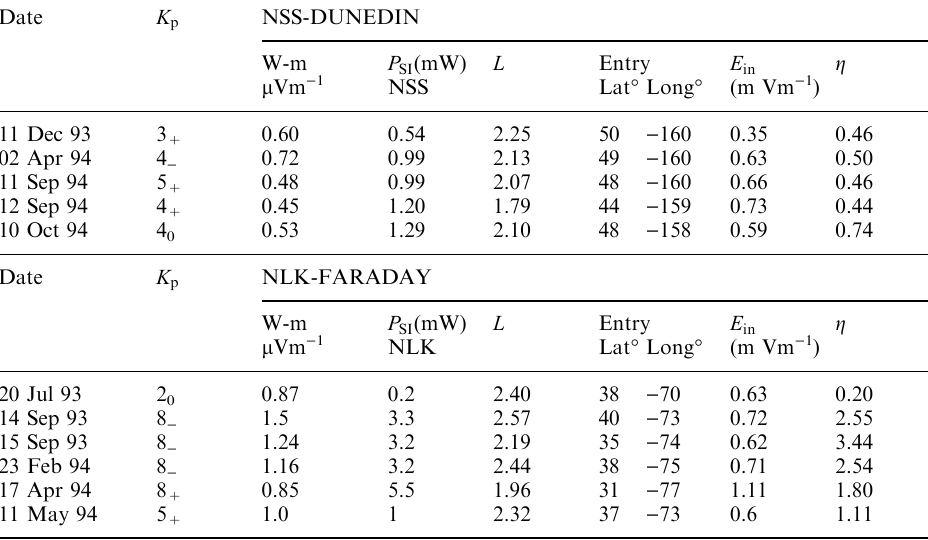
Table 1. The dates of occur- rence of whistler-mode signals and the transmitter they origi- nated from. The maximum va- lue of 3-hourly K p during the preceding 48 h is given. P SI and E in are determined using LWPC and the received whistler-mode signal amplitude (W-m). The duct e(cid:129)ciency (cid:133) (cid:103) (cid:134) is a simple ratio of duct output/input va- lues (see Sect. 4). The upper section of the table shows events based on signals from the NSS transmitter while the lower section shows events from